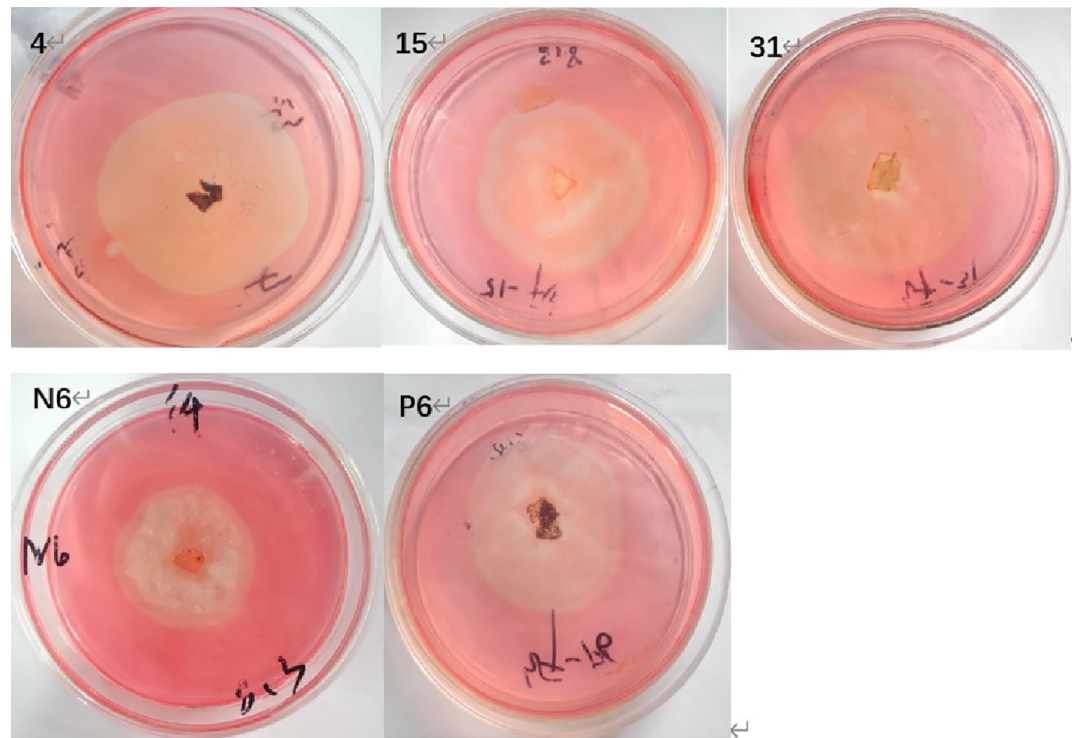
Figure 2. Growth diagrams of different strains on the Congo red agar plates on the day 7. Note : 4, 15, 31, N6 and P6 represent Colletotrichum acutatum, Nigrospora sphaerica , Exserohilum rostratum , Diaporthe phaseolorum , and Pestalotiopsis arceuthobii ,